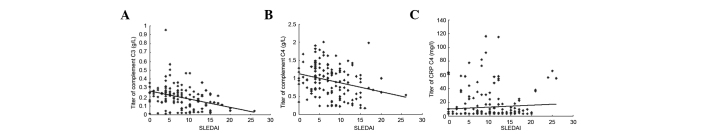
Relative analysis of the changes in C3, C4 and CRP with SLEDAI in SLE patients. The number of SLE patients was 347. Each point represents one pair of data (x and y value). There were significant negative and linear associations of (A) complement C3 (P<0.05, r=−0.535) and (B) complement C4 titers (P<0.05, r=−0.397) with SLEDAI. (C) No significant positive and linear association of CRP titer with SLEDAI rating was observed (P>0.05, r=0.068). CRP, C-reactive protein; SLE, systemic lupus erythematosus; RA, rheumatoid arthritis; SLEDAI, systemic lupus erythematosus disease activity index.